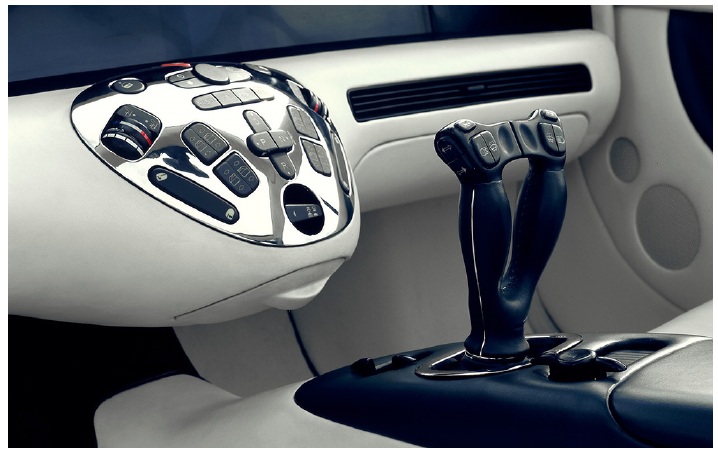
Figure 19. Futuristic Drive-by-Wire system of the Mercedes-Benz Company